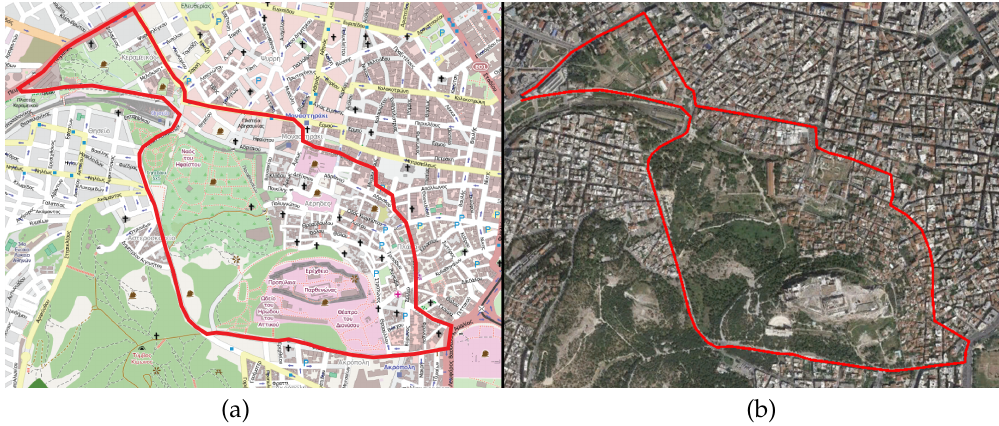
Figure 13: Boundary of project area over Open Street Map (a) and satellite image